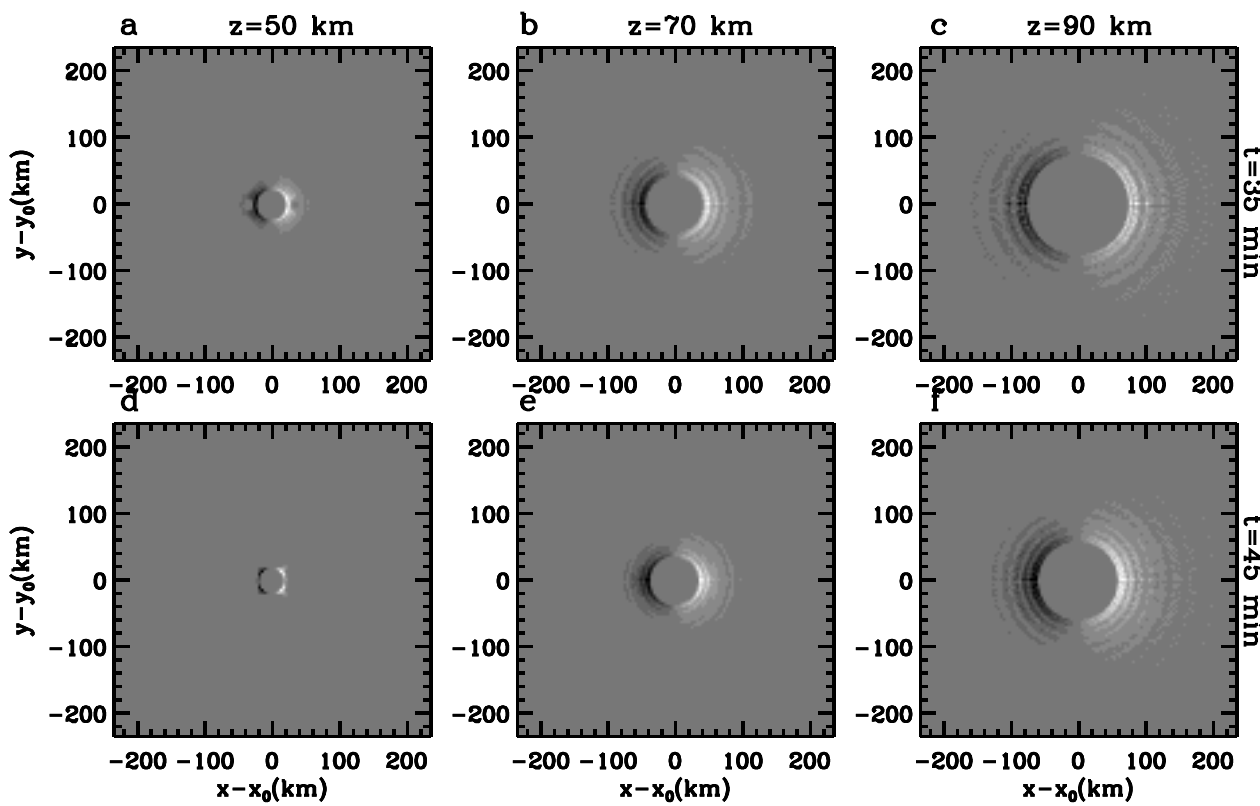
Fig. 18. Horizontal slices of the vertical flux of zonal momentum for the GWs ray traced from the same convective plume as in Fig. 17. Times and altitudes are the same as in Fig. 17. This plot is unsmoothed in x,y,z , and t . The resolution for the spectra is 1x = 8 .